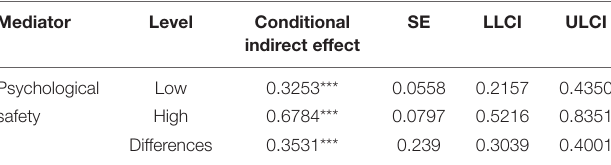
TABLE 8 | Moderated mediation model.